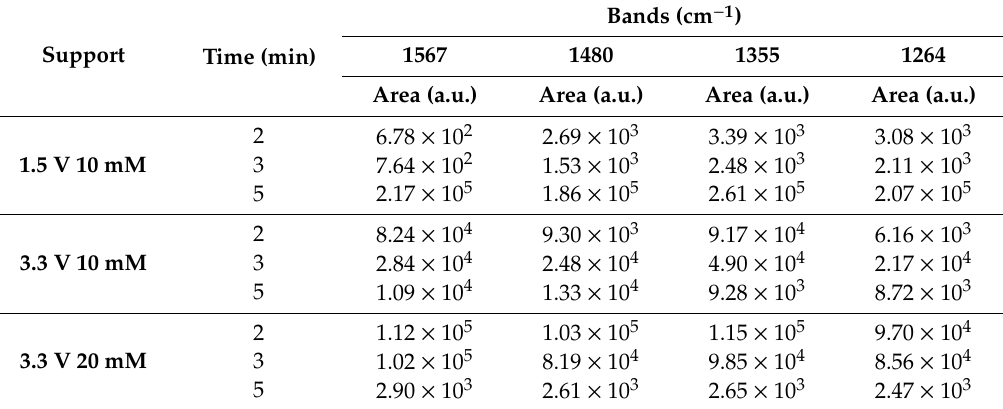
Figure 15. Calculated areas, in arbitrary unities (a.u.) for the bands: ( a ) at 1264 cm − 1 , ( b ) at 1355 cm − 1 , ( c ) at 1480 cm − 1 and ( d ) at 1567 cm − 1 of a 1 mM pyridine solution (0 min) and a 1 nM pyridine solution on each spectrum obtained from the SiO 2 –HA–Ag supports doped for 2, 3 and 5 min. Table 5. Calculated areas of the SERS enhanced bands.